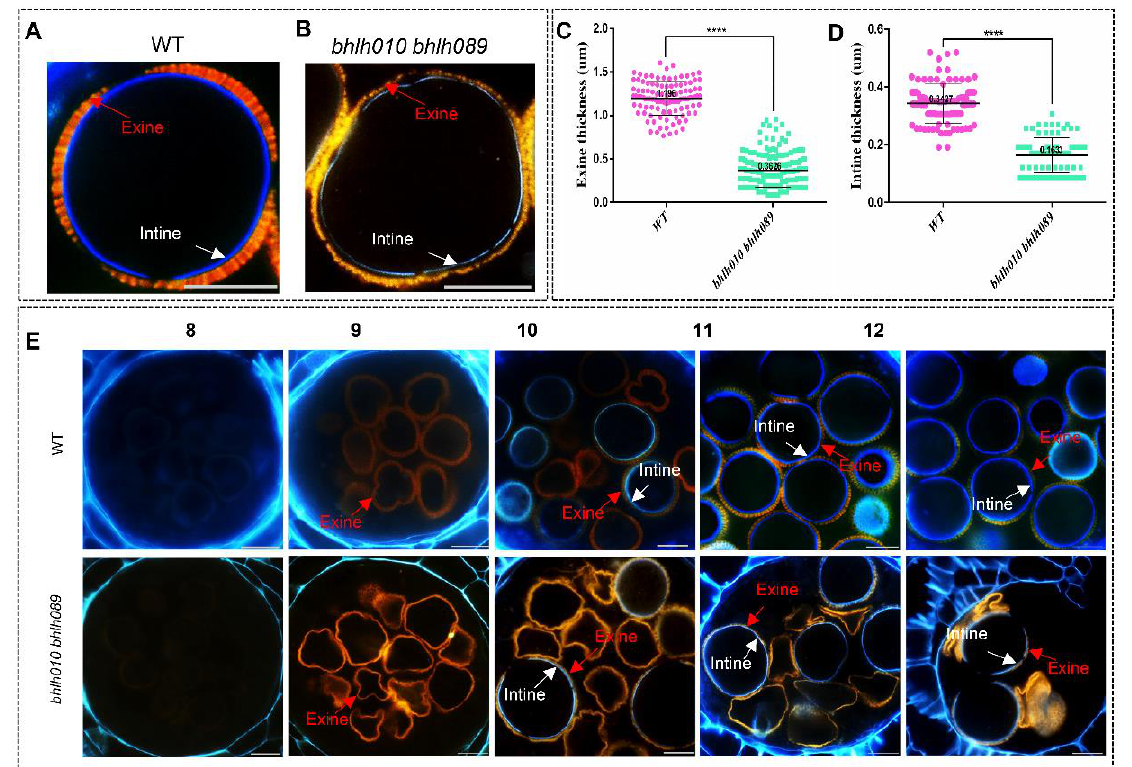
Figure 2. Pollen wall formation and differences of WT and bhlh010 bhlh089 double mutant plants. ( A , B ) Schematic diagram of differences in the pollen wall structure. ( A ) The exine and intine of pollen of WT are relatively uniform. ( B ) The pollen exine of the bhlh010 bhlh089 double mutant plants was uneven and partially missing, and the pollen intine was thin and discontinuous. Some pollen does not have an intine. ( C , D ) The thicknesses of the pollen exine and the pollen intine were calculated. The exine ( C ) and intine ( D ) of the pollen of WT are relatively uniform, with thicknesses of 1.196 ± 0.01813 μm ( n = 110) and 0.3626 ± 0.01420 μ m ( n = 179), respectively. The pollen exine ( C ) and intine ( D ) of the double mutant plants are not uniform, and the pollen intine is thin, with thick- nesses of 0.3427 ± 0.006770 μm ( n = 99) and 0.1633 ± 0.006480 μm, ( n = 87), respectively. Only the intine thickness of pollen with the intine is counted. The asterisks in ( C , D ) indicate a statistically significant difference from the WT control (****, p < 0.0001, S tudent’s t -test). ( E ) Transverse sections of the pollen wall development were performed in WT and the bhlh010 bhlh089 double mutant. There was an obvious difference between WT and the bhlh010 bhlh089 double mutant in stages 8 – 12. The white arrow indicates the intine, and the red arrow indicates the exine. Bars = 10 μm. The sections of the pollen wall development at stage 5 – 7 of WT and the bhlh010 bhlh089 double mutant in Supplemental Figure S1. To verify the stages when the pollen exine or intine defects started, the semi-thin sections of bhlh010 bhlh089 and WT anthers were performed to the pollen wall staining analyses. In WT pollen grains, the exine signal was faintly detected at anther stage 8 and significantly increased at level during anther stage 9 – 12 [77,78], suggesting the formation and development of exine; the intine signal started to appear at anther stage 10, later than the arising of the exine signal. However, in the bhlh010 bhlh089 pollen, although the emer- gence and developmental stages of the pollen exine were normal, the signal of the pollen intine was obviously weaker (Figure 2E, Supplemental Figure S2). In particular, only 36.3% of pollen that showed a detectable intine signal at anther stage 10 went through the developmental processes, although their final pollen wall architectures were distorted; the other 63.7% of the bhlh010 bhlh089 pollen that failed to form the intine subsequently underwent degeneration (Figure 2E). These above results strongly supported that bHLH010 and bHLH089 play important roles in regulating the formation of both the pol- len exine and intine.